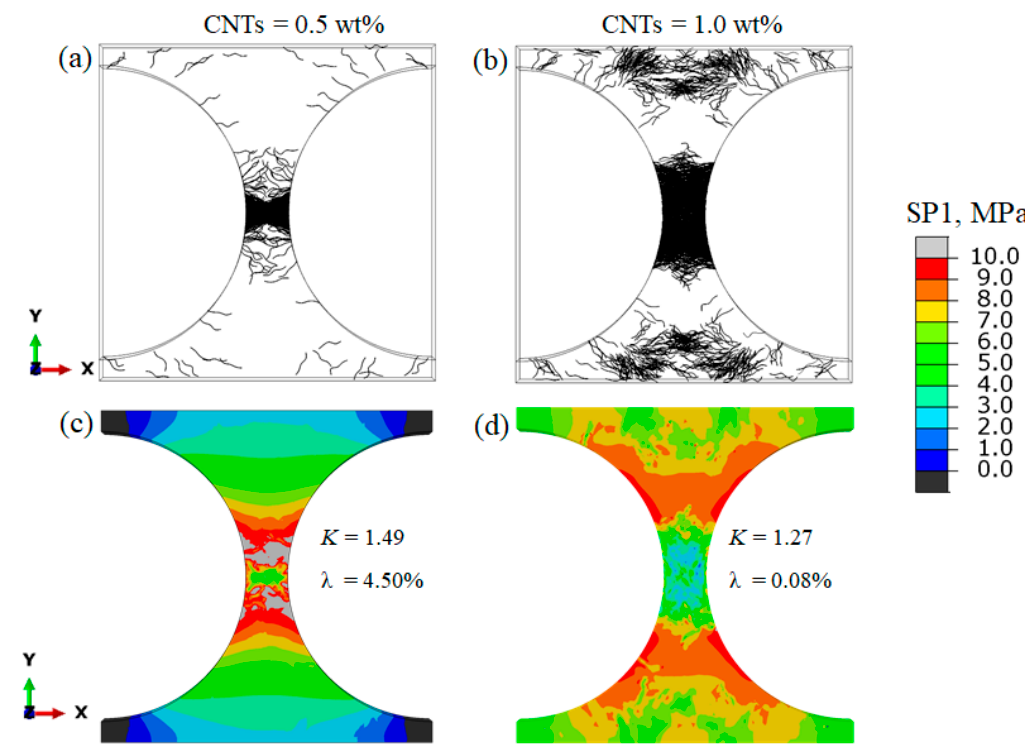
Figure 4. ( a,b ) Optimized CNT networks; ( c,d ) the respective stress fields in the matrix. CNT content: 0.5 wt% ( a,c ) and 1.0 wt% ( b,d ).